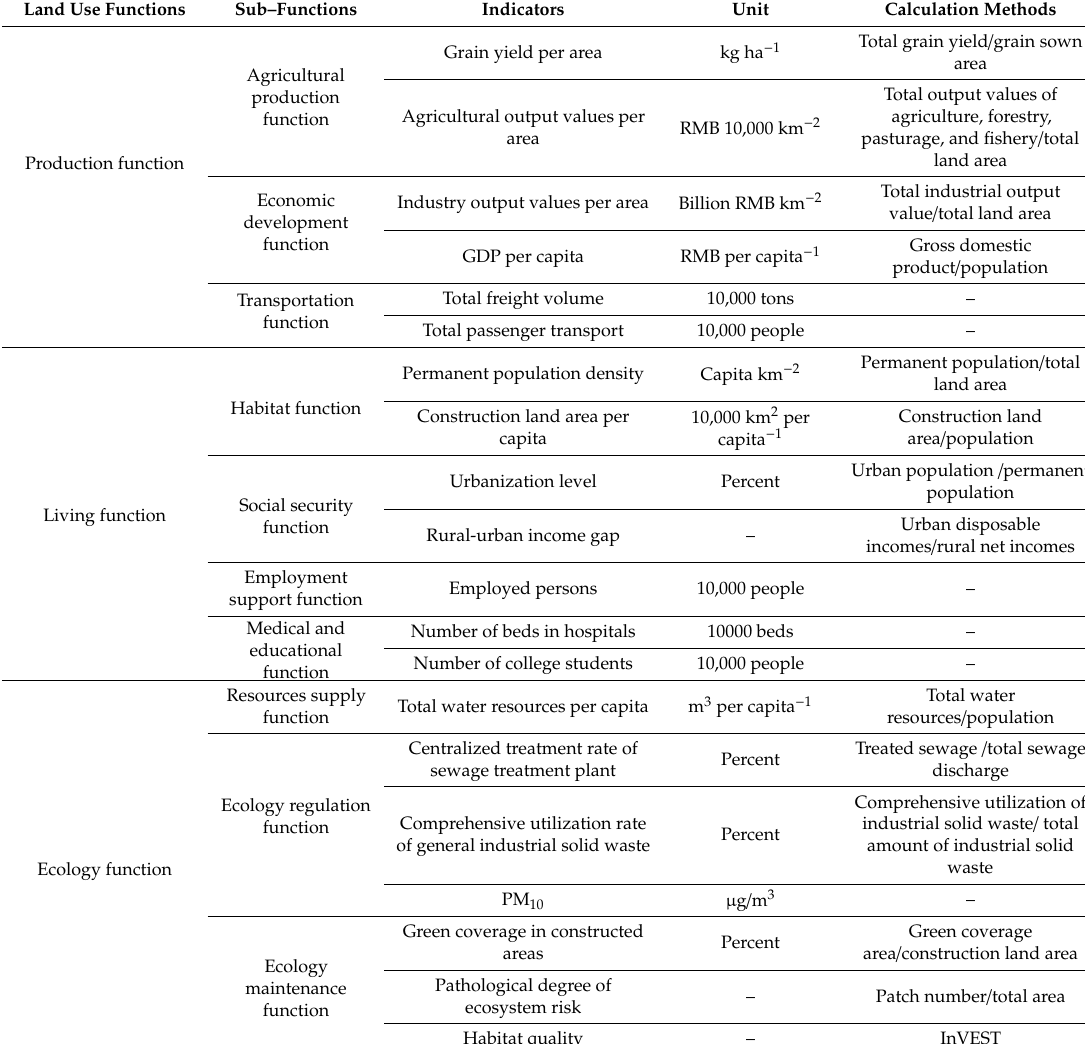
Table 1. Assessment of the index system for production-living-ecology land use multifunctionality in the Beijing-Tianjin-Hebei